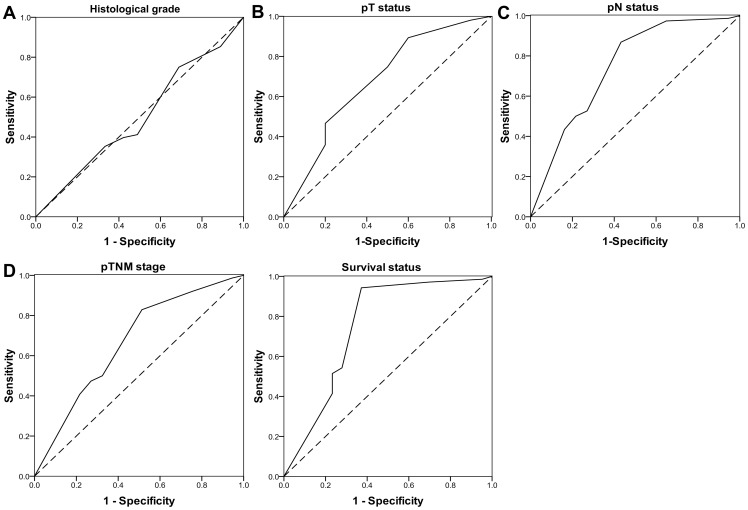
ROC analysis for the immunohistochemistry cut-off score.The sensitivity and specificity for each clinical outcome were plotted (A–F). Accuracy was measured by the area under the ROC curve (AUC). The dashed line indicates a reference test threshold with an AUC of 0.5. The AUC > 0.5 with a statistical significance represents a worthy test. pT status, depth of tumors; pN status, LN status.